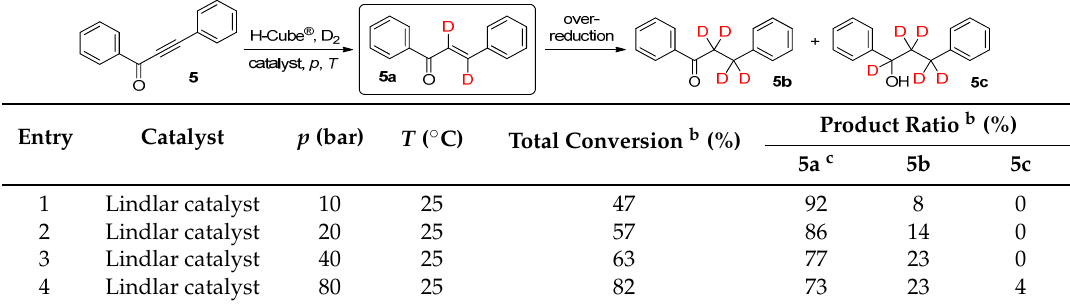
Table 1. Continuous-flow deuteration of 5 a .